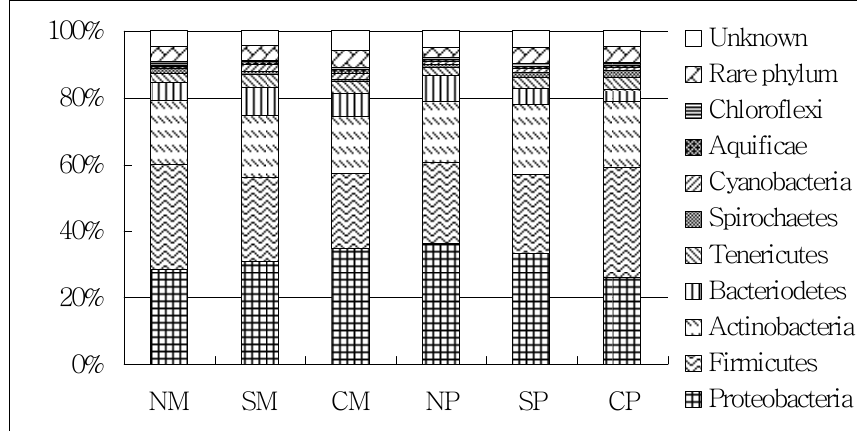
Figure 3. The groups of maize and peanut rhizosphere soil bacterial phyla under different intercropping patterns. NM: non-separated maize; SM: semi-separated maize; CM: completely separated maize; NP: non-separated peanut; SP: semi-separated peanut; CP: completely separated peanut.